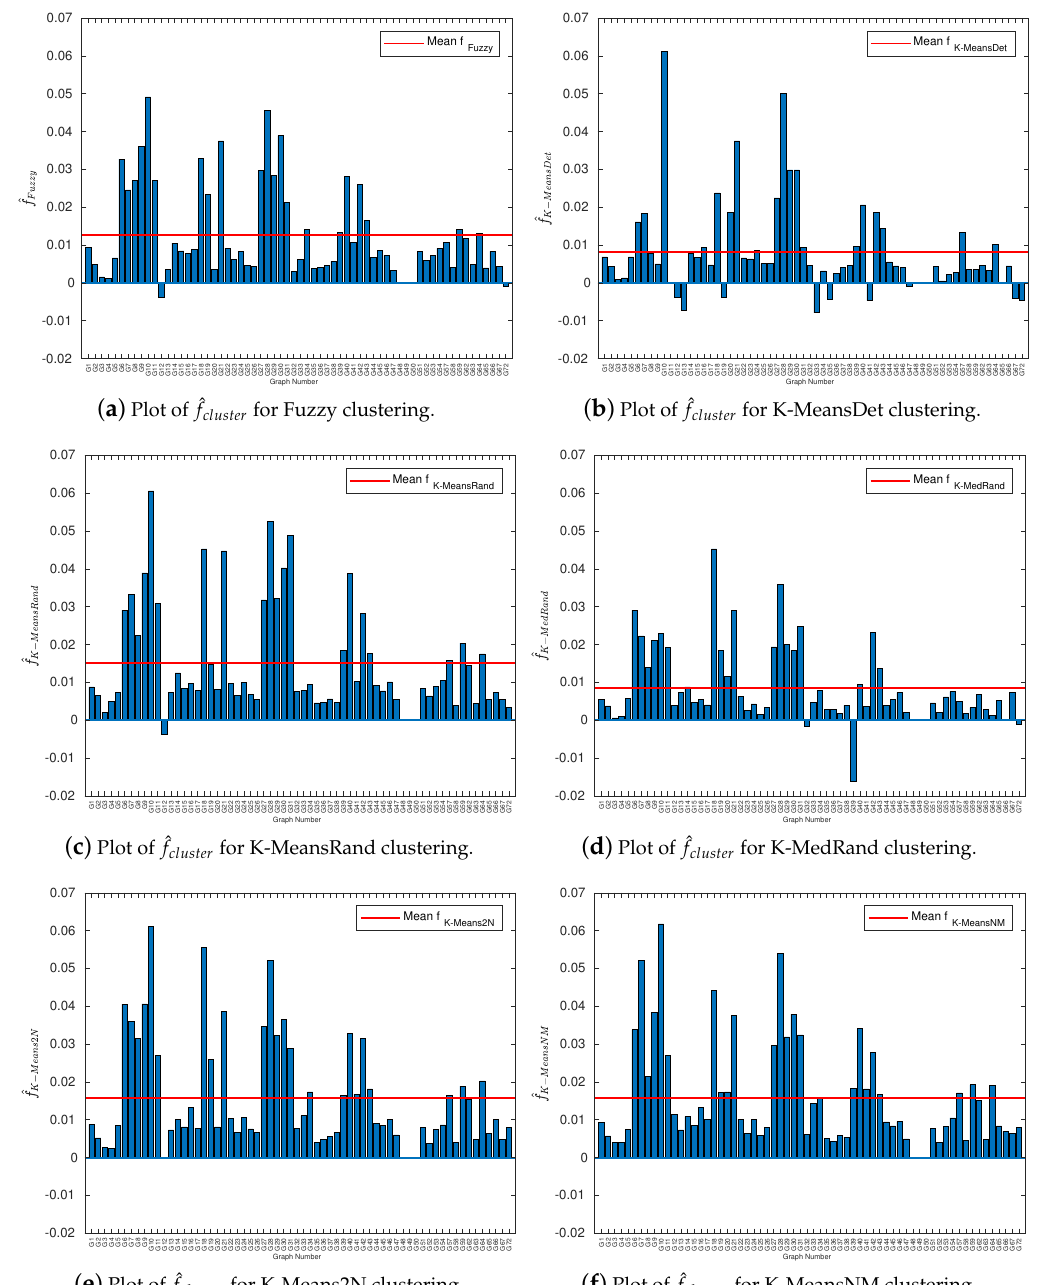
( e ) Plot of ˆ f ( f ) Plot of ˆ f cluster for K-Means2N clustering. cluster for K-MeansNM clustering. Figure 2. Comparison between the cut value found by clustering algorithms and RR, using ˆ f cluster as the comparison. The horizontal axis represents the graph number, i.e., graph G i is shown in position i . The red line indicates the average over the benchmark set. Positive values indicate that the clustering solutions are superior to the RR